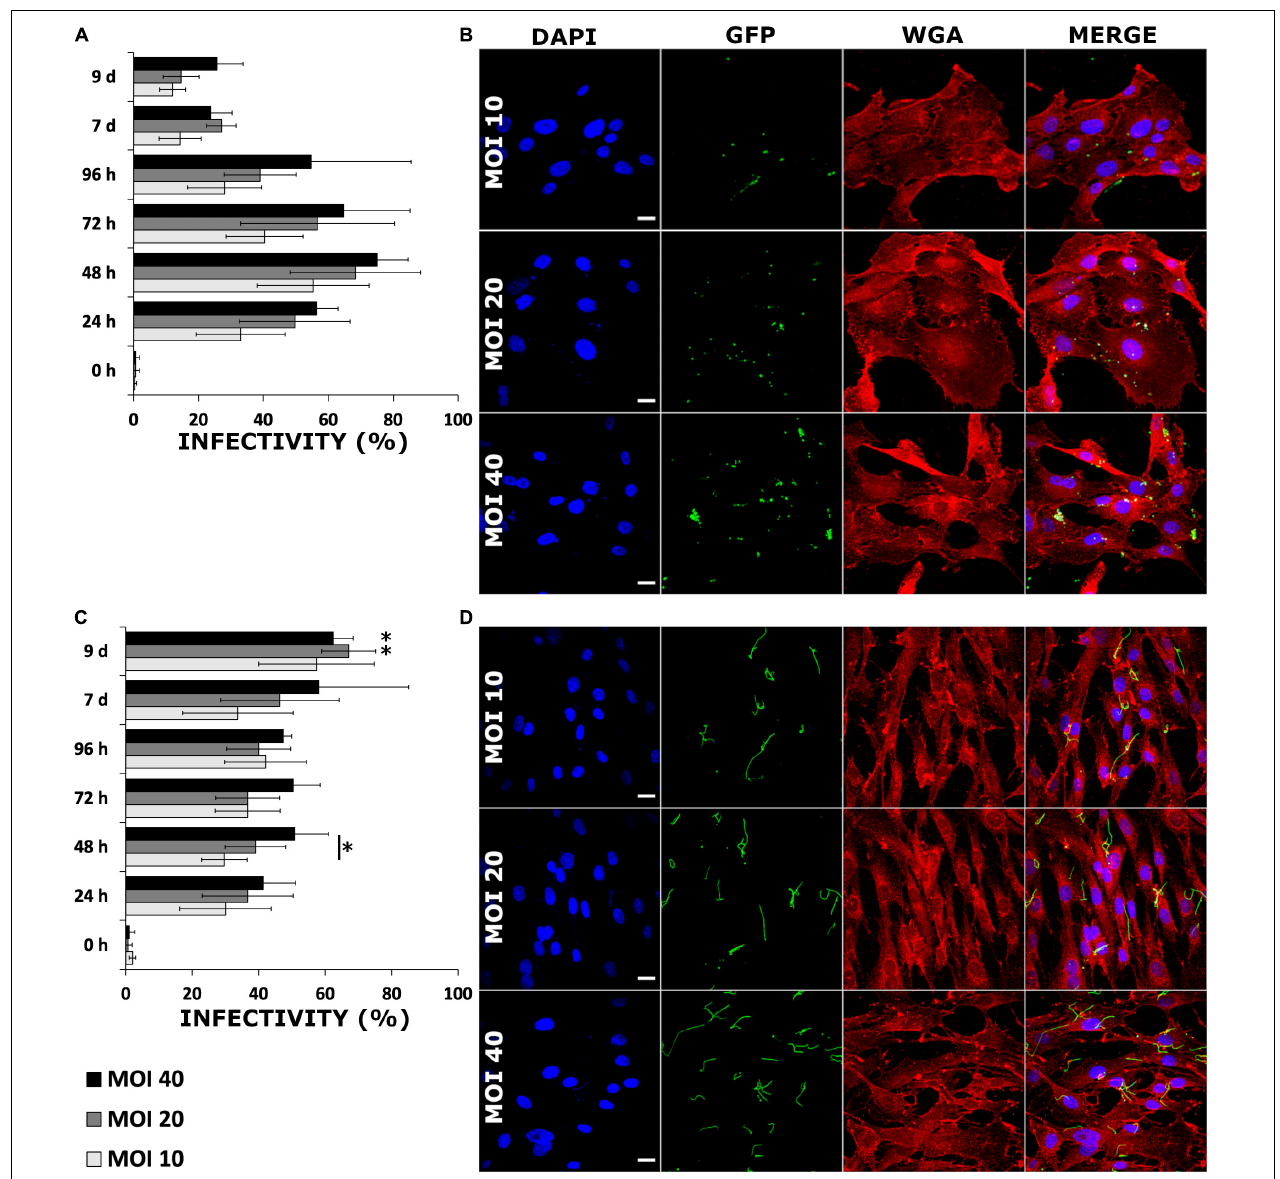
FIGURE 2 | Borrelia burgdorferi infected human cells in a dose dependent manner without losing infectivity even after 9 days. SW1353 (A,B) and BJ (C,D) cells were infected with B. burgdorferi strain GCB726 with green fluorescent protein (GFP) ( B. burgdorferi ). A cell was considered infected when B. burgdorferi was attached to or inside a cell. Three different multiplicity of infections (MOIs) (10, 20, and 40) were examined over 9 days. In total, 300 cells were counted from three replicate experiments ( n = 300). Standard deviation of means from three repeated experiments. Statistical significance with paired independent Student’s t -test (* p ≤ 0.05) was performed for both MOIs in a time point (line with asterisk), as well as, between 24 h and the rest of the time points (asterisk only). Representative confocal micrographs from the 48 h time point for infected SW1353 (B) , and BJ (D) cells. The nucleus (DAPI) in blue, B. burgdorferi (GFP) in green, the cell membrane wheat germ agglutinin (WGA) in red and a merged image of all three channels. Scale bars 20 µ m.